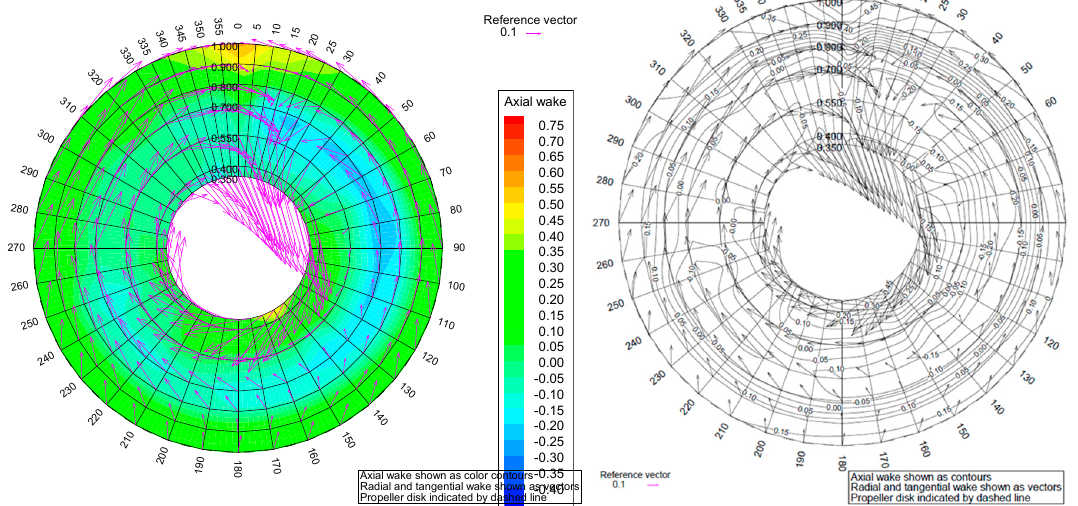
Figure 22. 3D wake measurements at a plane midway between the propeller and rudder, with a working propeller, with PSS, at 14 kn.